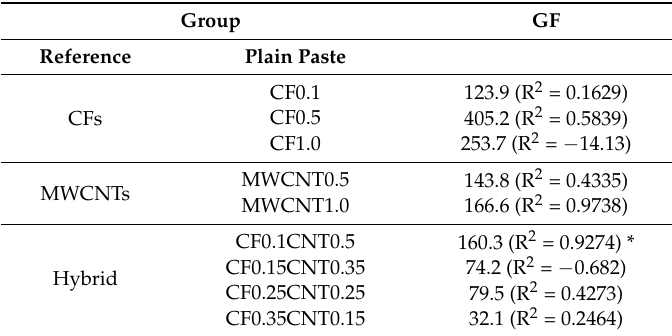
Table 4. Gauge Factor (GF) obtained from the experiments.